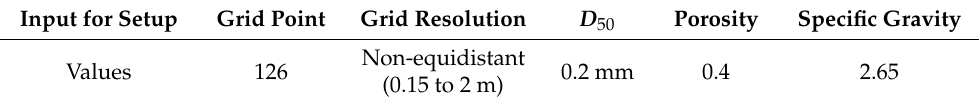
Table 2. Summarized general input information for numerical setup provided by the previous study